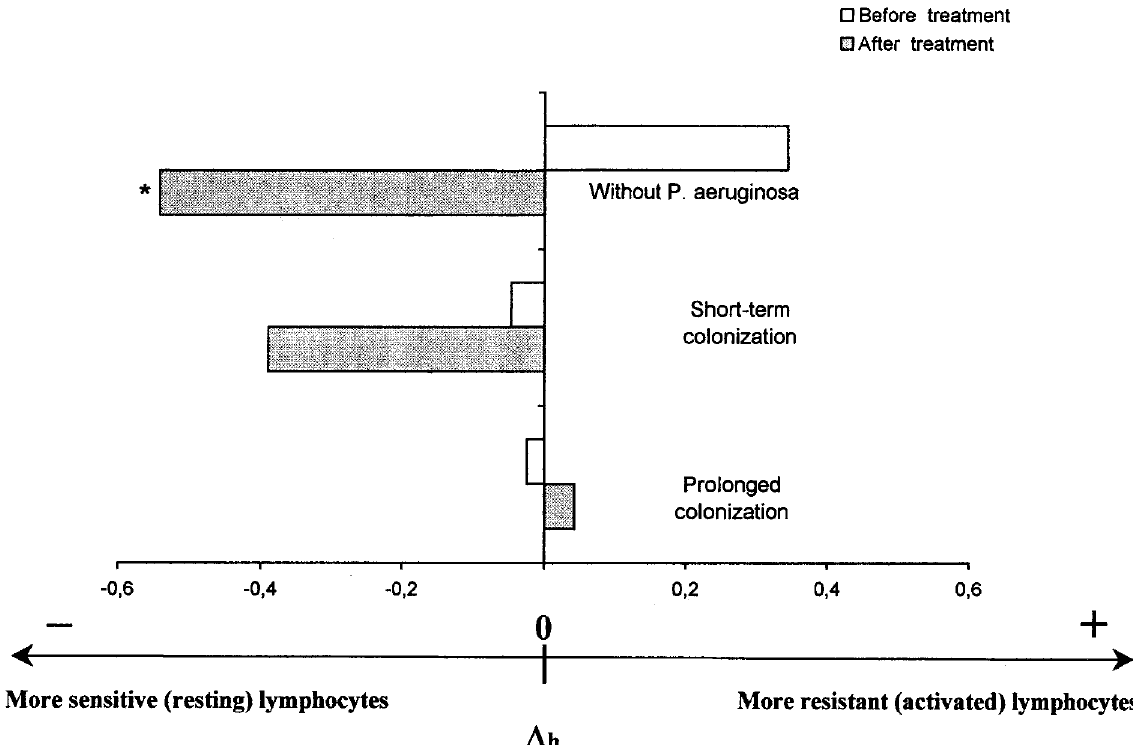
FIG. 6. Peripheral blood lymphocyte (PBL) susceptibility to antiproliferative effect of dexamethasone in CF patients. Inhibition degree of PHA-induced lymphocyte proliferation by different concentrations of dexamethasone was evaluated. The cell sensitivity is presented as a mean of D h values (see Material and Methods). The asterisk indicates the D h values in P. aeruginosa -free patients before and after antibiotic treatment are significantly different ( p <0.05; two sample Student’s t -test), i.e. after treament PBL became more sensitive to glucocorticoid